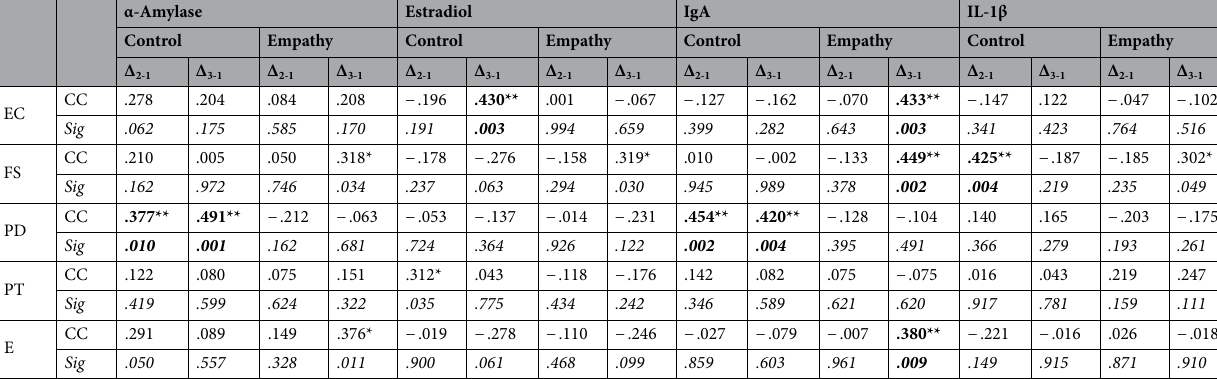
Table 5. Spearman correlation between trait empathy as determined by SPQ and normalized salivary biomarker levels. EC empathic concern, FS fantasy, PD personal distress, PT perspective taking, E empathy score (= EC + FS + PT), CC correlation coefficient, Sig significance; *significance level 0.05; **significance level 0.01. CCs with P < 0.01 were highlighted in